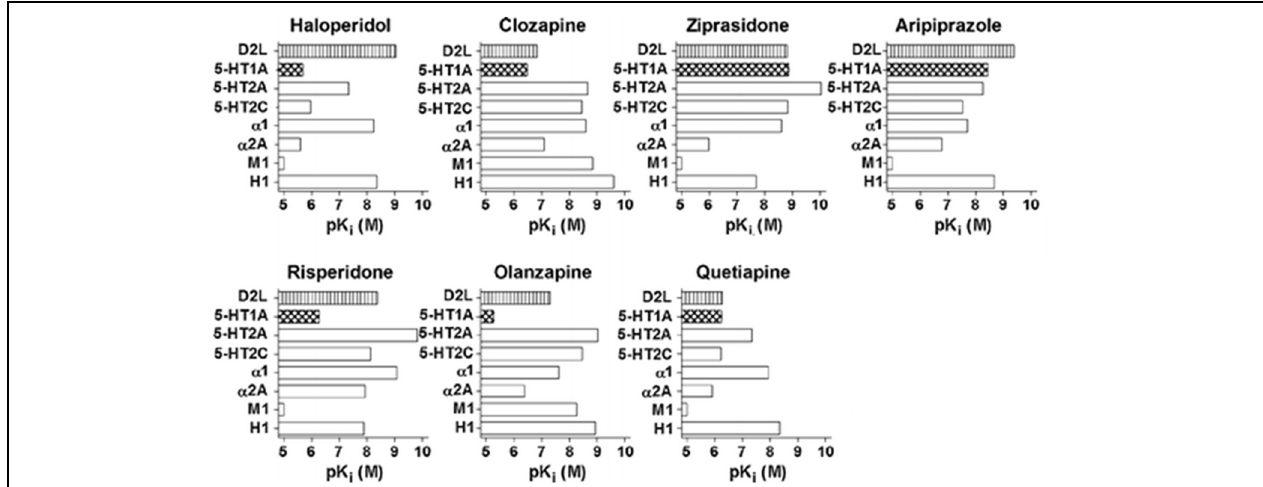
FIGURE 5 | Receptor binding profiles of antipsychotic drugs. A larger pKi value represents a stronger affinity for the particular receptor. [Data from Newman-Tancredi and Kleven (2011)].